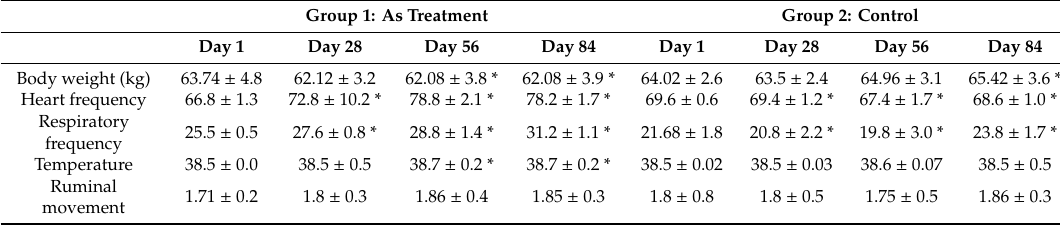
Table 3. E ff ects of arsenic on body weight and physiological conditions in Group 1 vs. Group 2. Group 1: As Treatment